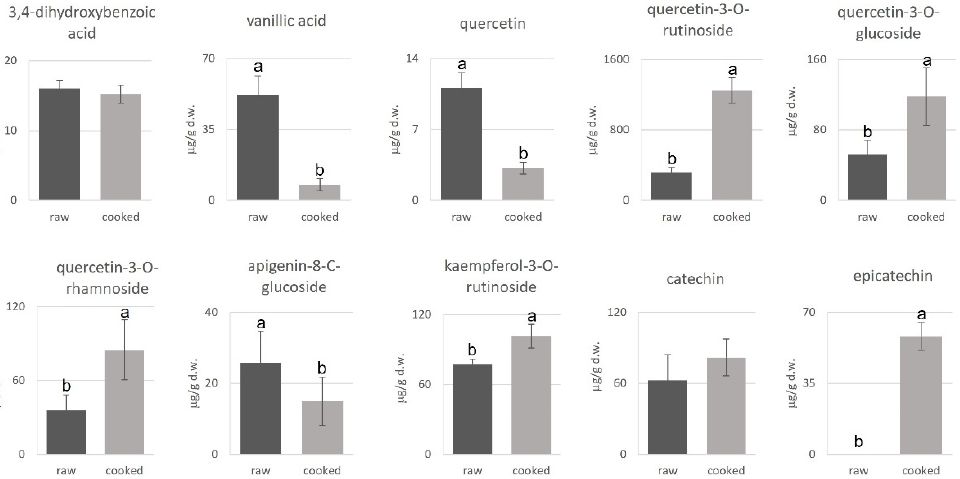
Figure 3. Cooking effect on the average content of each phenolic compound in raw and cooked samples. Different letters mean significant differences ( p ≤ 0.05). No letters mean no significant differences.